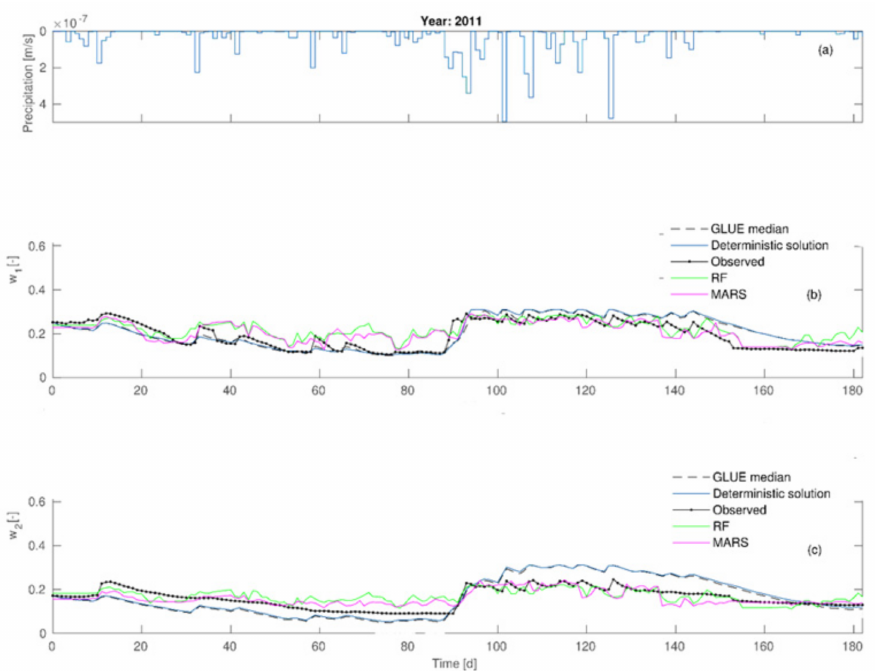
Figure 5. Comparison of the modeled and observed soil moisture contents by Deardorff model for the first calibration stage: ( a ) precipitation rates ( b ) w 1 -soil moisture content of the first layer ( c ) w 2 -soil moisture content of the second